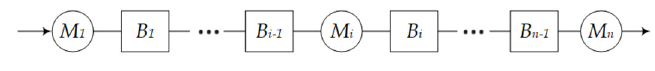
Figure 1. A multistage serial manufacturing system.